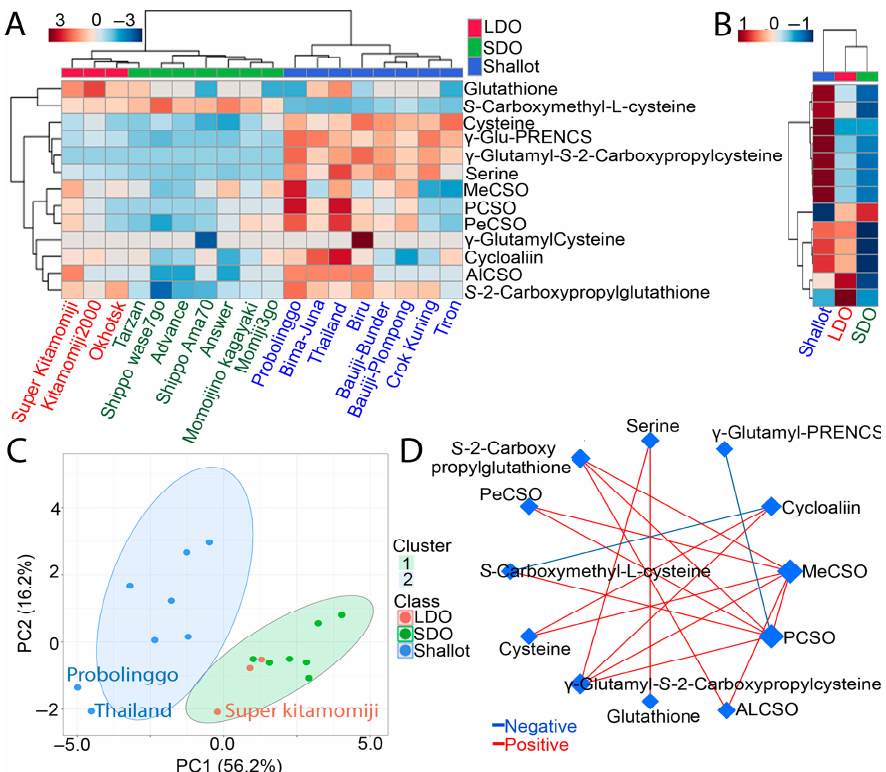
Figure 5. Heatmaps, principal component analysis (PCA) and correlation network of the investi- gated Indonesian shallot landraces and Japanese long-day and short-day onions (LDOs and SDOs, respectively), based on organosulfur compounds. ( A , B ) Heatmaps of the normalized organosulfur compound contents in the investigated genotypes. Color bar indicates high (red) and low (blue) contents of organosulfur compounds. ( C ) PCA-score plot of the investigated genotypes based on organosulfur compounds. ( D ) Metabolite-metabolite correlation using Pearson correlation coeffi- cient.